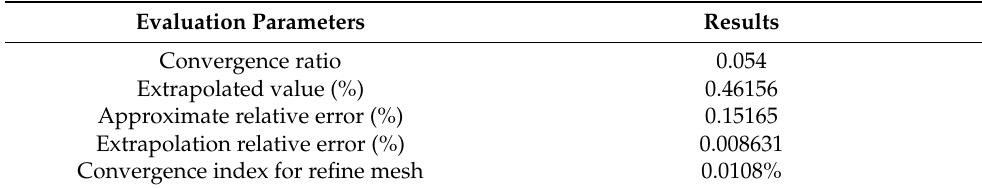
Table 2. The mesh convergence study in calm water.